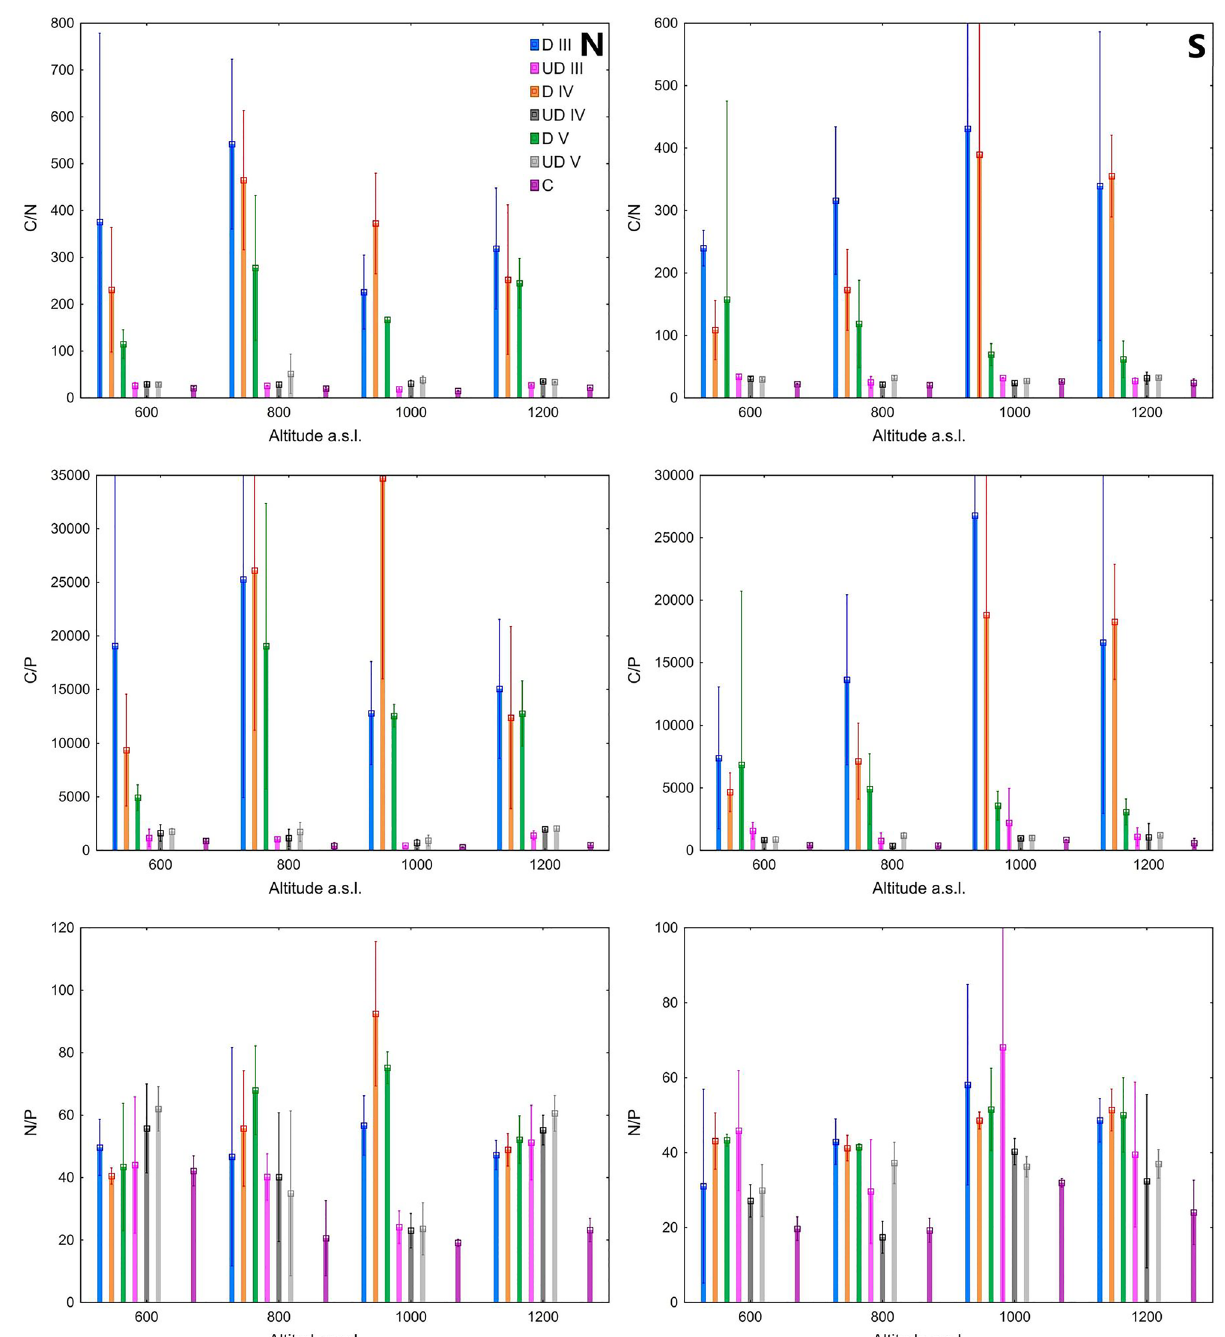
Figure 2. C/N/P stoichiometry of wood (D) and soil samples ( UD soil samples under deadwood; C control soil) in relation to exposure, altitude and decay clases (III, IV and impact on the soil, which is consistent with the results of previous studies 41 . The significantly higher nitrogen content in the soil, compared to the control variant (without the influence of wood) was found in all localization conditions under decaying wood in V DC. In the case of phosphorus, we did not find such an unambiguous effect. More phosphorus than controls accumulated under the V DC wood on most of the tested surfaces but there were exceptions to this rule. At the cooler exhibition, such exceptions occurred at an altitude of 800 and 1000 m above sea level, at the highest altitude at the warmer exposure. Phosphorus is considered to be an ingredi- ent limiting the development of microorganisms decomposing organic matter 43,44 . There are reports of a higher accumulation of this macroelement in cooler locations, where the growing season is shorter and probably the entire P pool is not used by soil microorganisms 45,46 .